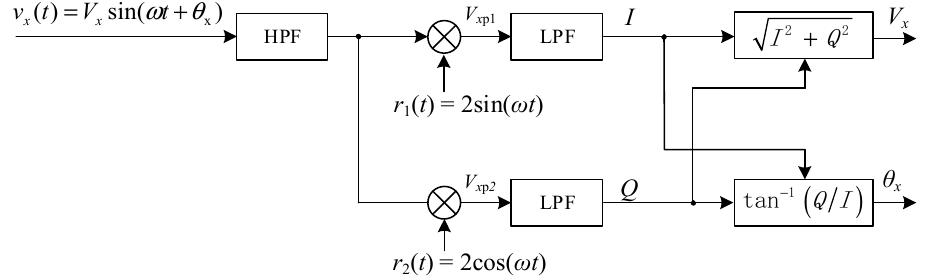
Figure 11. Functional block diagram of algorithm for uniaxial digital orthogonal phase-locked amplifier. It is used to calculate the voltage amplitude and phase of the X-axis. The calculate method in Y-axis and Z-axis are similar).